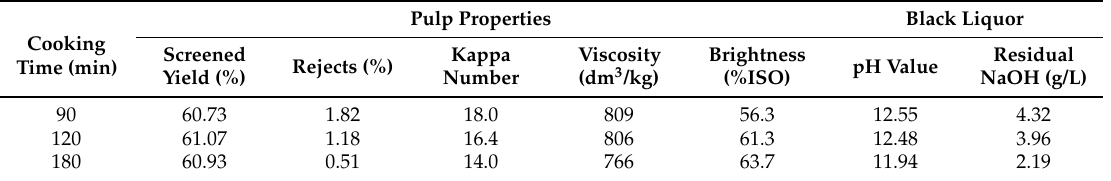
Table 4. Effects of cooking time at 100 ˝ C on soda-oxygen pulping of the